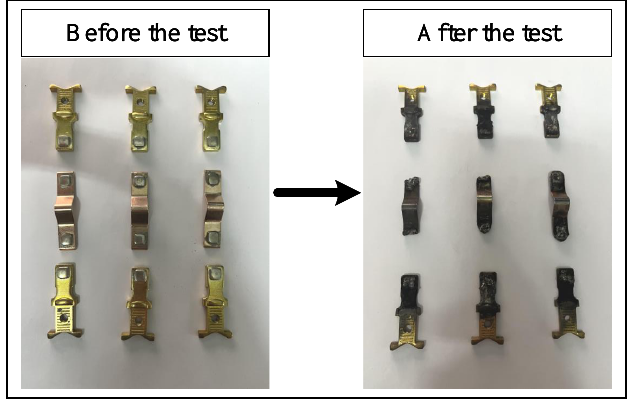
Figure 14. Contrast diagram of contact